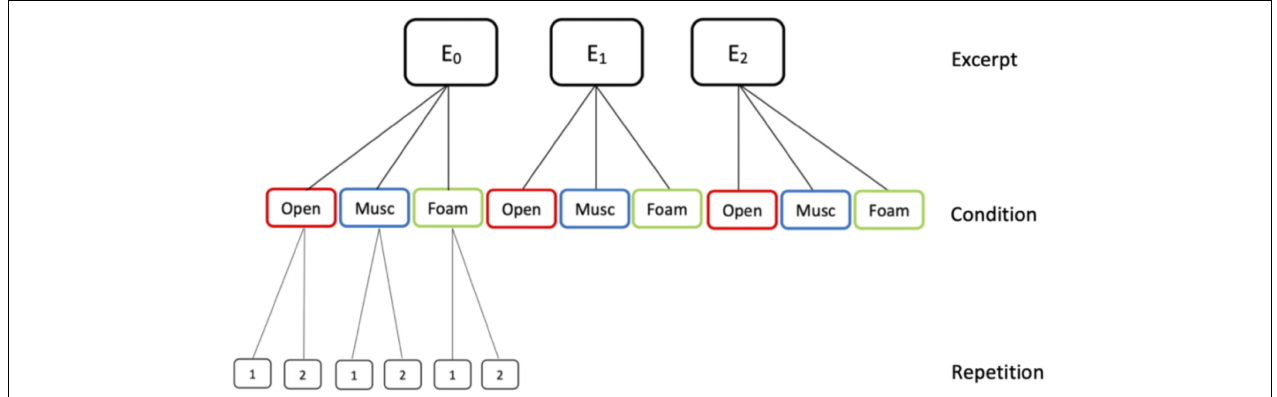
FIGURE 1 | Experimental design. E0 was a highly familiar excerpt played from memory, while E1 (of medium familiarity) and E2 (of low familiarity) were sight-read. All excerpts are performed by all 17 participants in three hearing conditions, namely Open without earplugs, Music while wearing musician earplugs, Foam while wearing foam earplugs. Eleven participants further repeated E0 in all three hearing conditions to investigate acclimatization effects.